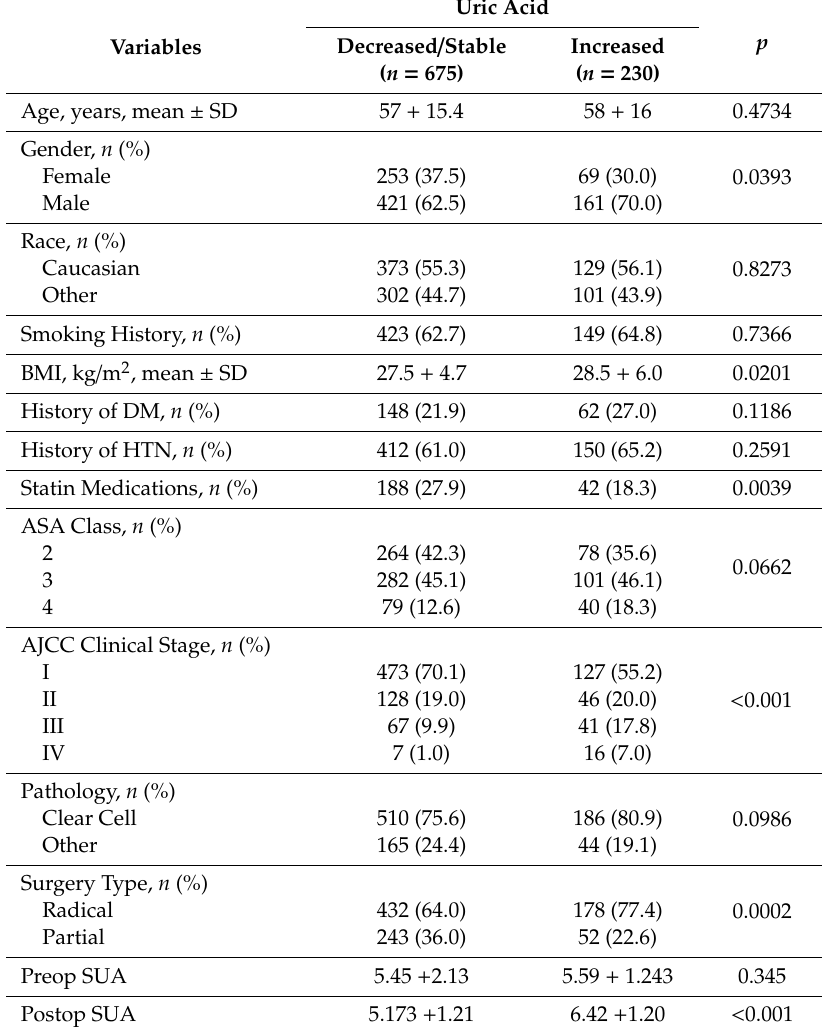
Table 1. Demographics and disease characteristics in the decreased / stable uric acid and increased uric acid groups.